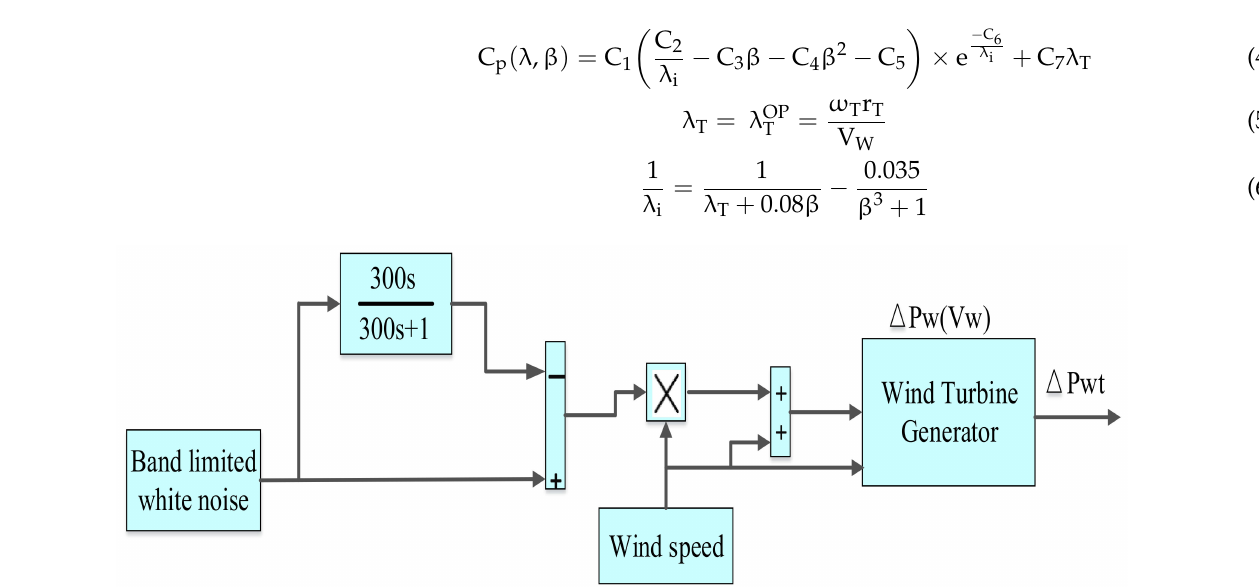
Figure 3. The implemented model of wind power using MATLAB/Simulink program (R2015a).